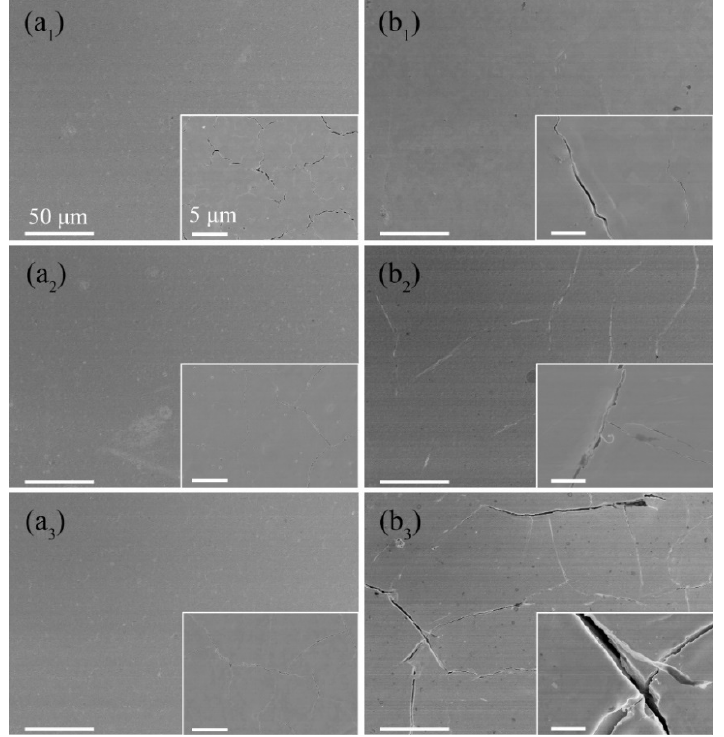
Figure 5. SEM images of the W-150W-10 film ( a 1 ,a 2 ,a 3 ), and bulk W ( b 1 ,b 2 ,b 3 ), irradiated by HIPIB at RT; the energy density was ~1 J/cm 2 , with pulses of 10 ( a 1 , b 1 ), 50 ( a 2 , b 2 ), and 100 ( a 3 , b 3 ), respectively. Insets show the corresponding magnified images. The corresponding scale is uniform.